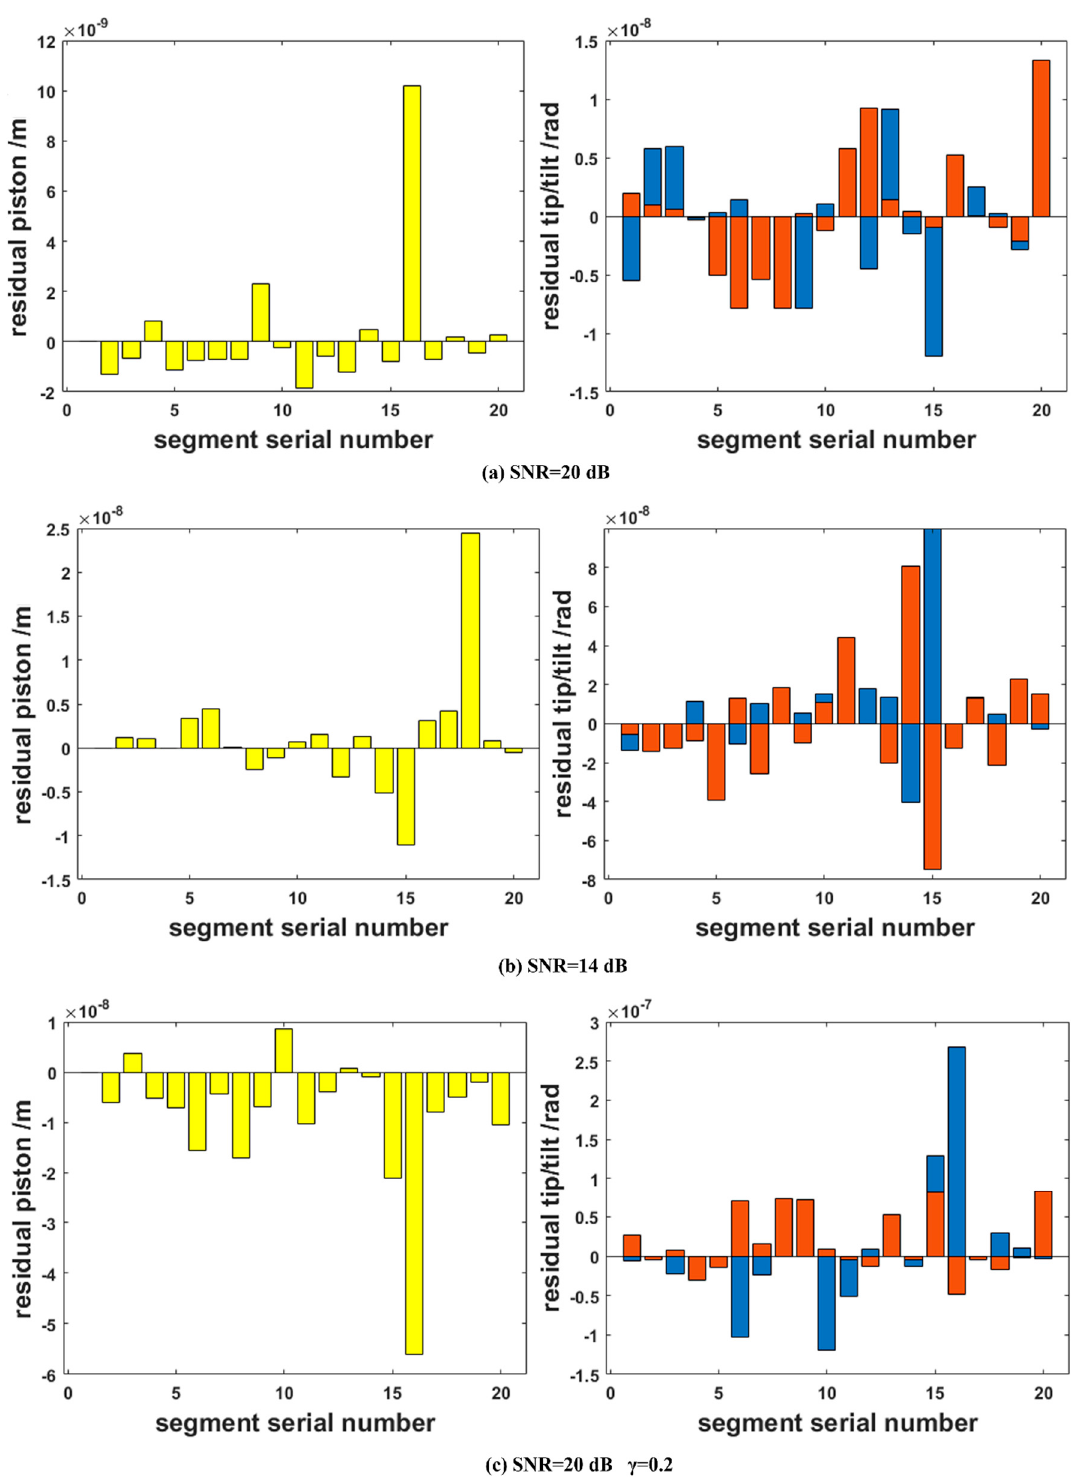
Figure 4. Simulation results with a random co-phasing error | ∆ p i | ≤ 1 µ m, | ∆ tx i | ≤ 5 µ rad , | ∆ ty | ≤ 5 µ rad ; the synthesis wavelength is 10.55 µ m (630 and 670 nm, respectively), ( a ) left is the residual between the real piston and measurement piston for all segmented mirrors, and right is the residual of the tip error (blue bar) and tilt error (red bar); ( a , b ) are in different SNRs, and ( c ) is the situation when the contrast ratio is low.